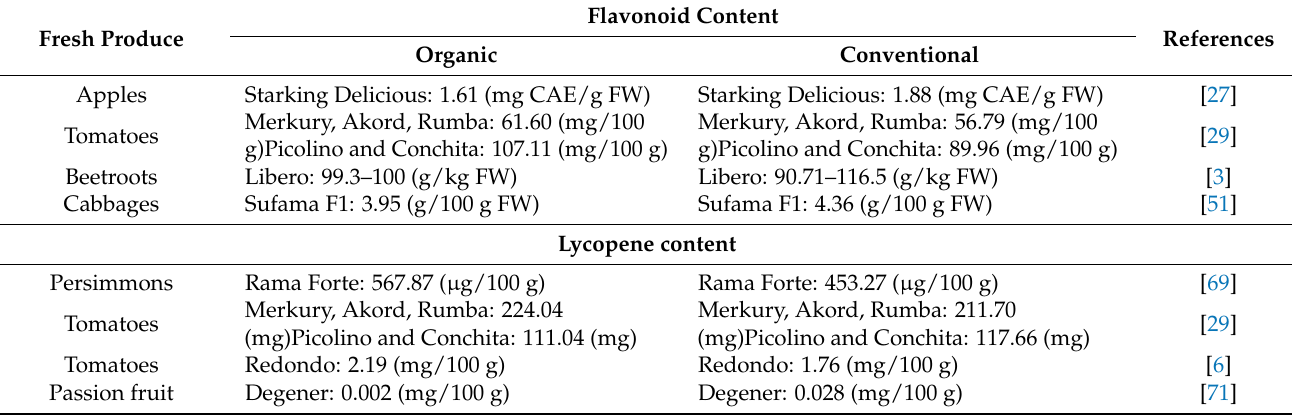
Table 10. Flavonoid and lycopene content of organic and conventional fresh produce. Flavonoid